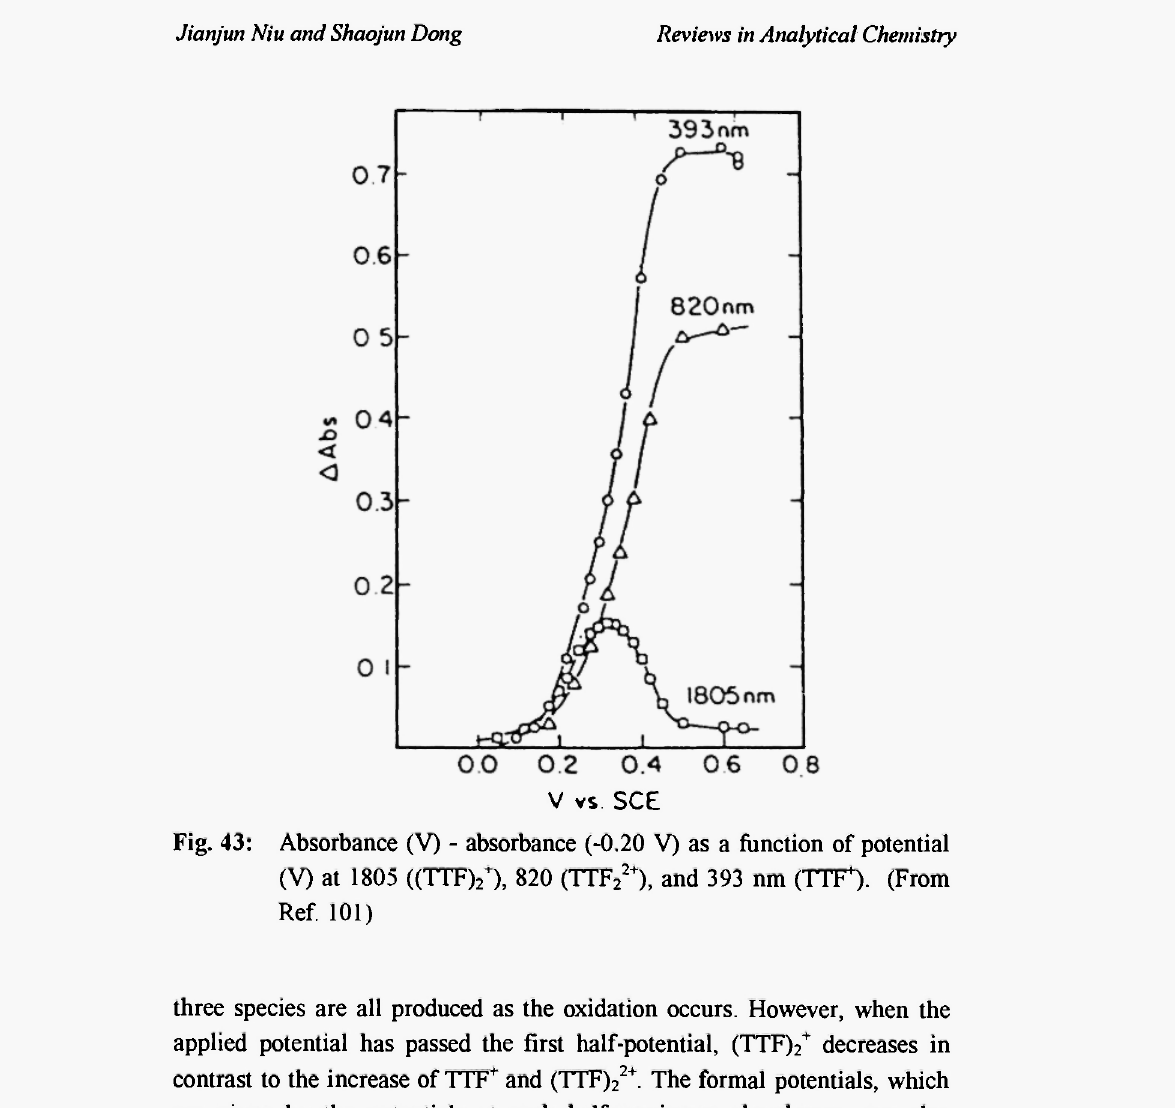
Fig. 43: Absorbance (V) - absorbance (-0.20 V) as a function of potential (V) at 1805 ((TTF) 2 + ), 820 (TTF 2 2+ ), and 393 nm (ΊΓΤΤ). (From Ref.